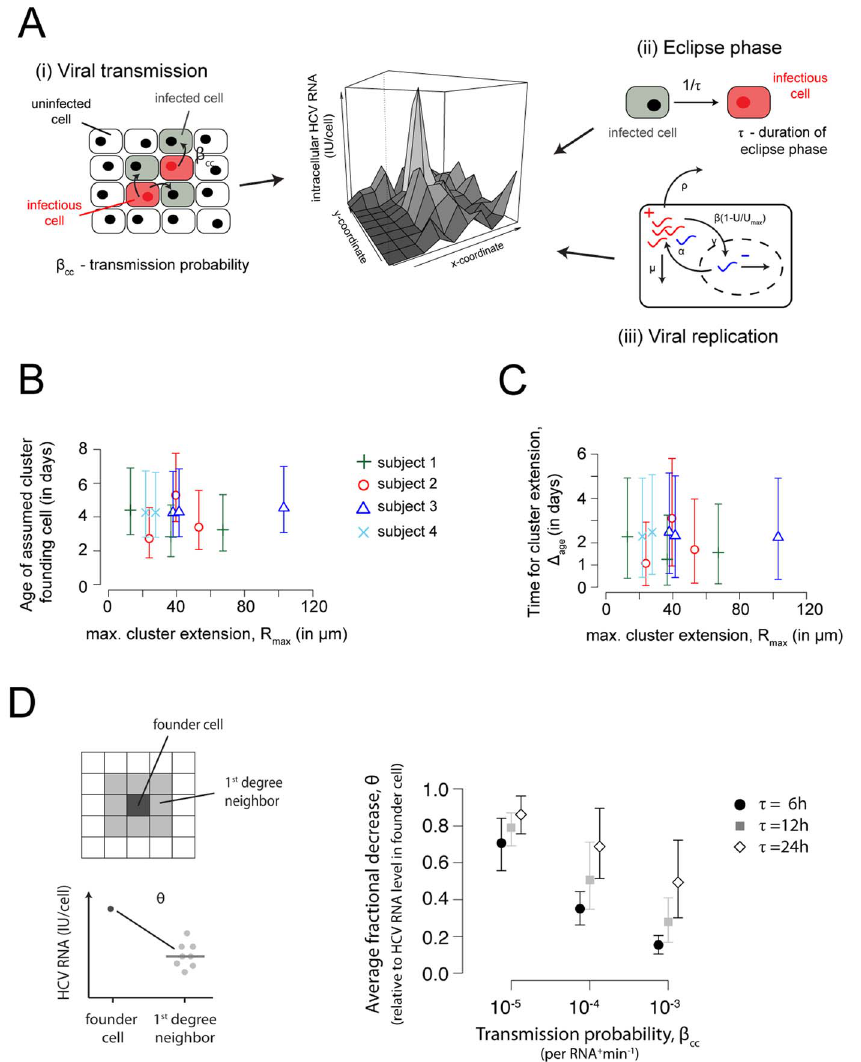
Figure 4. Cluster structure and age of infection. ( A ) Factors influencing the observed viral landscape in a cluster including (i) viral transmission, (ii) the viral eclipse phase, and (iii) intracellular viral replication. ( B, C ) Relationship between the maximal cluster extension and the age of the assumed founder cell of the cluster ( B ) and the time until this cluster extension was possibly reached, D age ( C ), i.e., the difference between the age of the assumed founder cell and cells that were more recently added to the cluster. Estimates were obtained using the model on intracellular HCV replication discussed in the text. The mean and the 2.5% and 97.5% percentiles of 10,000 bootstrap replicates for each individual cluster are shown. ( D ) Comparison of the average fractional decrease in intracellular HCV RNA, h , between the founder cell and the surrounding cells of a cluster comprising 9 cells. Expansion of individual foci was simulated in a 2D-grid with different assumptions for the average duration of the eclipse phase t , and the probability for viral transmission, b cc . We simulated 1000 individual foci and selected all foci showing clusters comprising 9 cells with radial spread. The average fractional decrease is calculated relative to the amount of viral RNA within the founder cell of the cluster. The mean and 95%- percentiles are shown. For a detailed description of the simulation environment see Supporting Information (Text